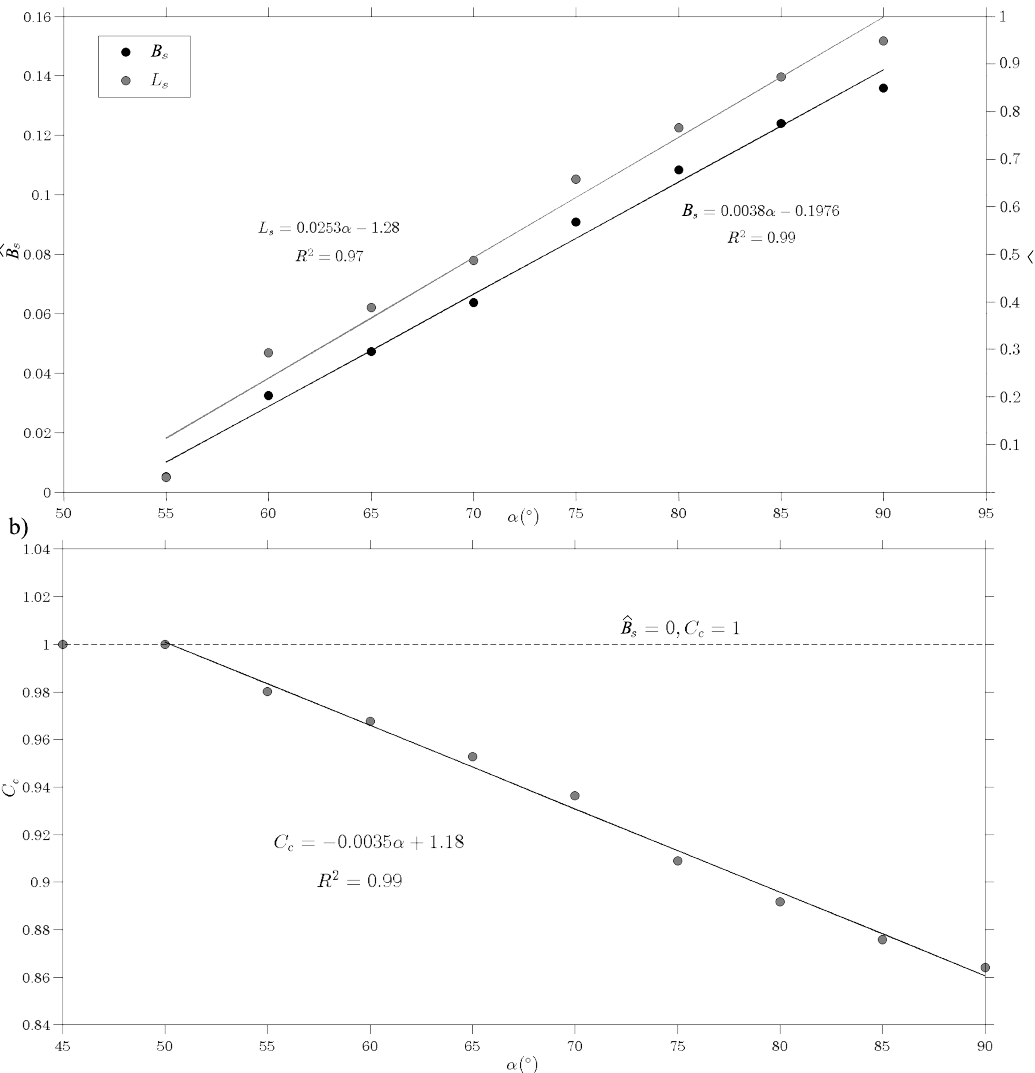
Figure 16. ( a ) non-dimensional width and length of the separation zone as a function of α ; ( b ) distribution of the contraction coefficient as a function of α at ˆ z ∼